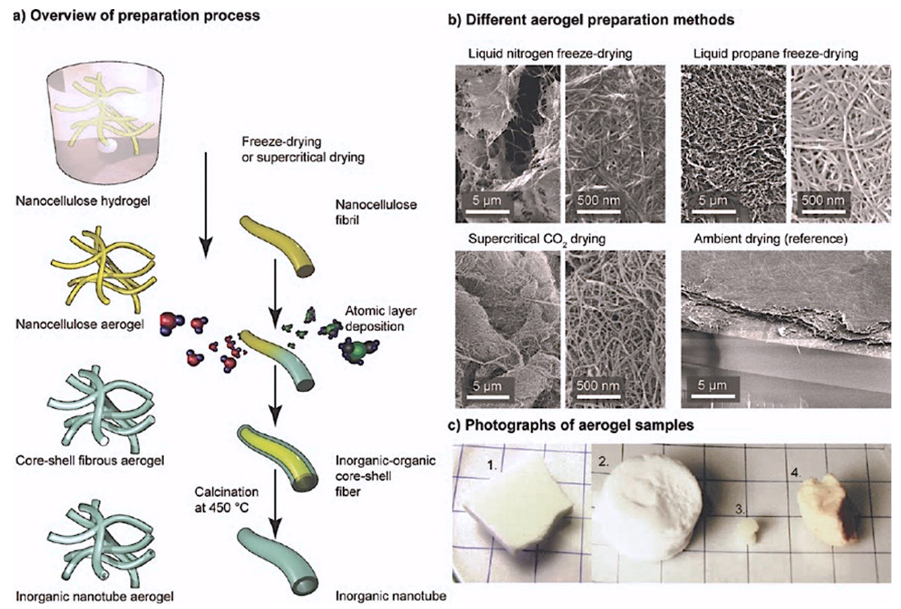
Figure 9. ( a ) The schematic presentation of the inorganic hollow nanotube preparation process. First the nanocellulose hydrogel is dried to obtain the aerogel, which is then coated with inorganic oxides using the ALD method to form composite organic/inorganic nanofibers. Finally, the composite was calcined to inorganic hollow nanotubes. ( b ) The SEM images demonstrating the effect of different drying methods: freeze-drying by freezing the nanocellulose hydrogel in liquid nitrogen, followed by the sublimation of ice in vacuum, leads to aerogels with sheet-like aggregates; freeze-drying in liquid propane leads to fibrillar aerogels with suppressed aggregation, given the sample is sufficiently thin; supercritical-drying leads to fibrillar aerogels without aggregates, even in thick samples; drying at ambient conditions leads to the collapse of the structure. ( c ) Photographs of the aerogel samples: (1) Liquid propane freeze-dried aerogel of 2 mm thickness; (2) supercritically-dried sample with ca. 12 mm in diameter and 10 mm in height; (3) atmospherically-dried sample that completely collapsed. Wet dimensions were the same as in the supercritically-dried sample; (4) Supercritically- dried aerogel after ALD showed a slight yellow color on the surface. Reprinted with permission from [238]. Copyright 2011 American Chemical